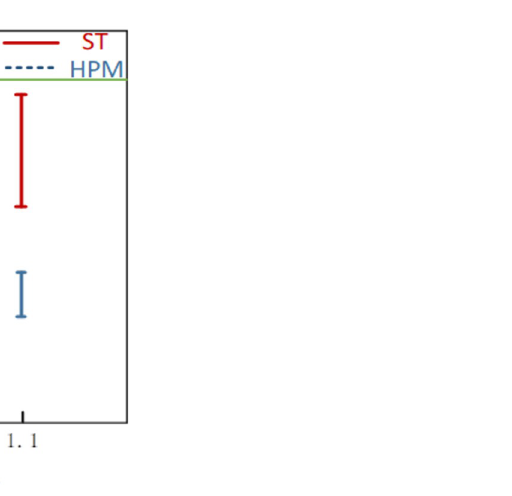
Fig 14. The optimal solutions under different